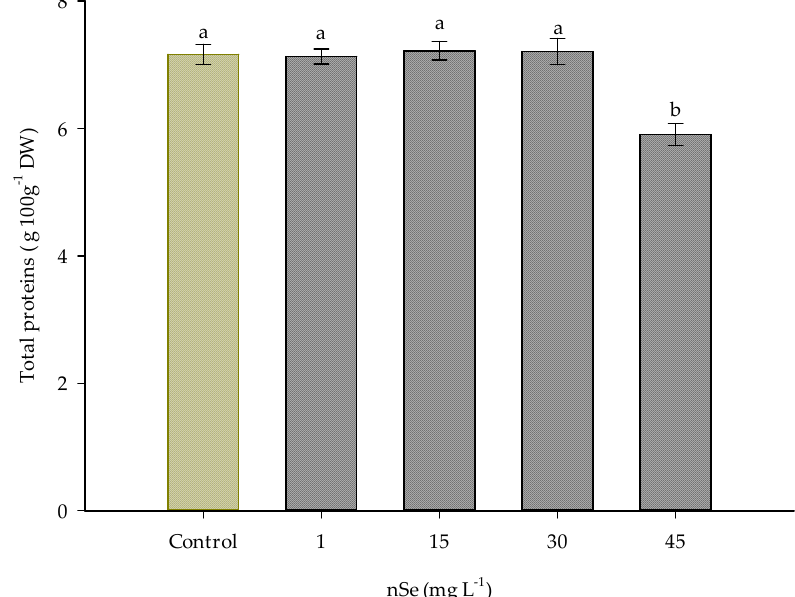
Figure 4. Total protein content in Jalapeño pepper fruits with nSe. DW: dry weight. Different letters indicate differences between treatments (Tukey test p ≤ 0.05). n = 5 ± standard error.